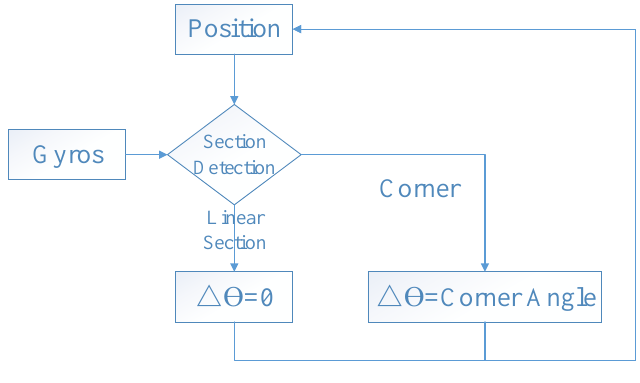
Figure 7. The flow of map